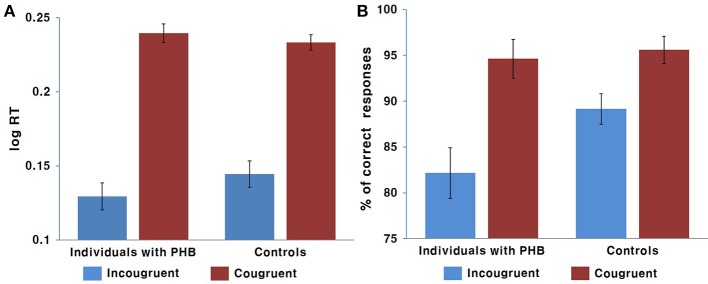
Behavioral results. (A) Mean response time in ms. (B) Mean response accuracy as a percentage. Error bars indicate the standard error of the mean.